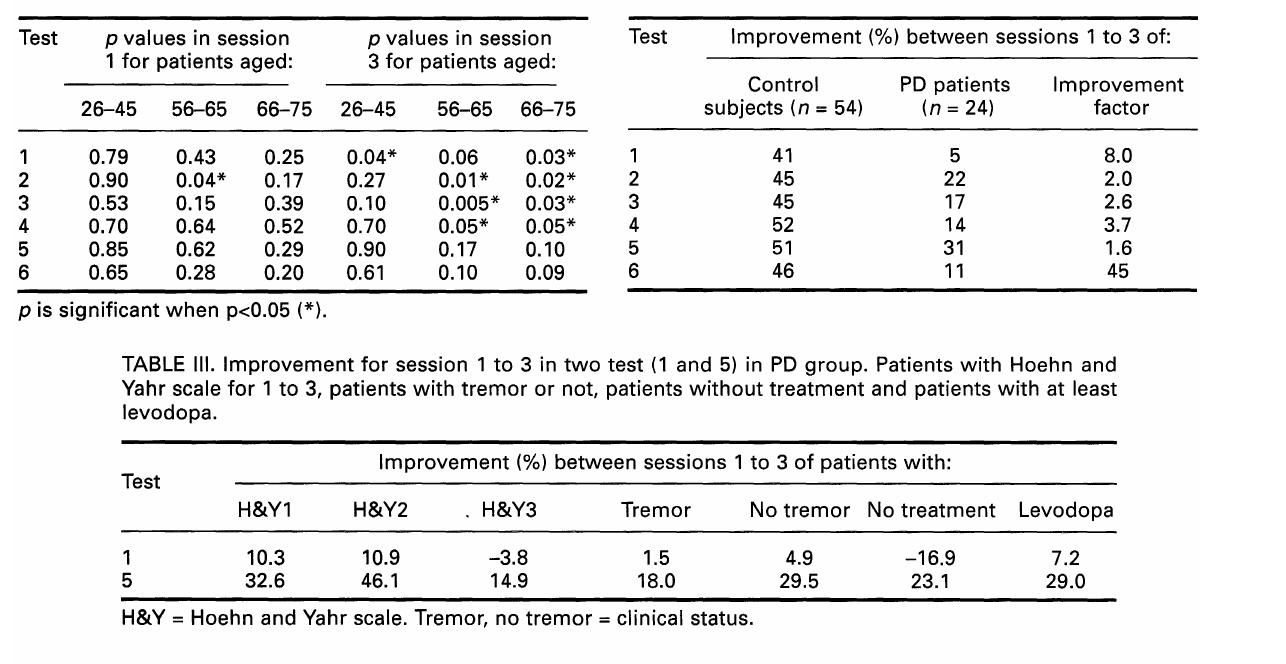
TABLE I. Results of Student's t-test in six tests. Comparison of time response in session 1 and 3 for PO patients and their controls.